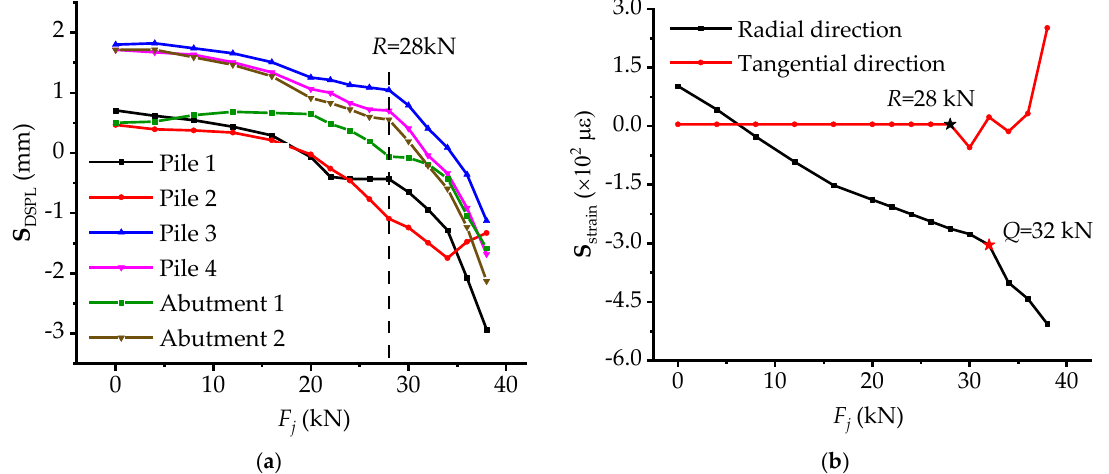
Figure 6. The curves of strain-based and DSPL-based stressing state modes with respect to load for piles and abutment: ( a ) The S DSPL - F curve for piles and abutment in tangential direction; and ( b ) The S strain - F for pile 2.